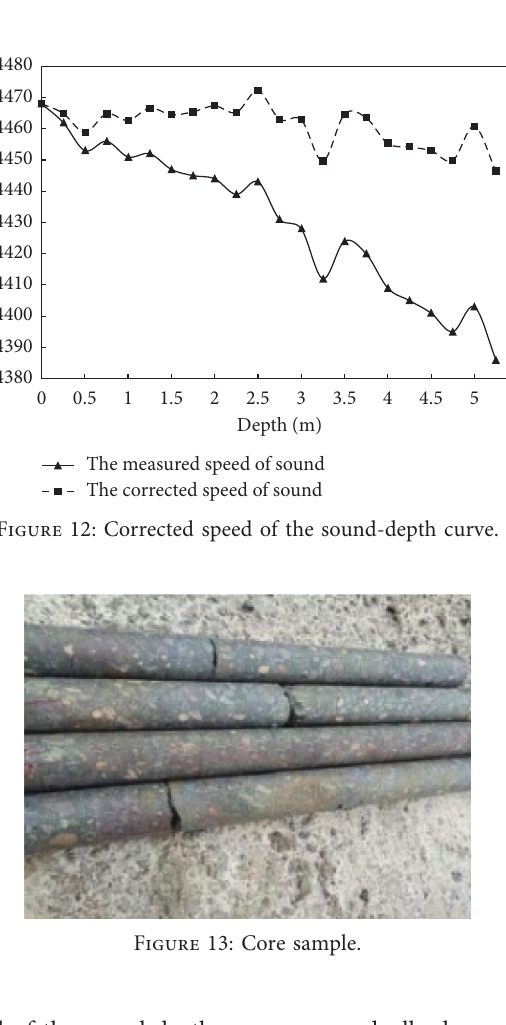
Figure 11: RS-ST01 C ultrasonic detectors.